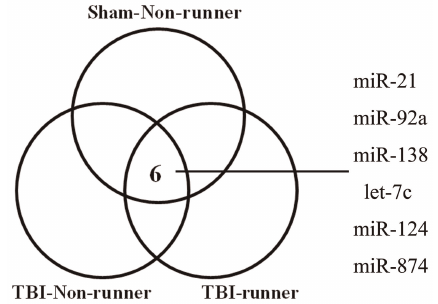
Figure 4. Differential expressions of miRNAs among sham-non- runners, traumatic brain injury (TBI)-non-runners and TBI- runners. The ideogram showed there were 6 miRNAs (miR-21, miR-92a, miR-874, miR-138, let-7c and miR-124), which were different between the sham-non-runners and TBI-non-runners groups, as well as between the TBI-non-runners and TBI-runners groups.